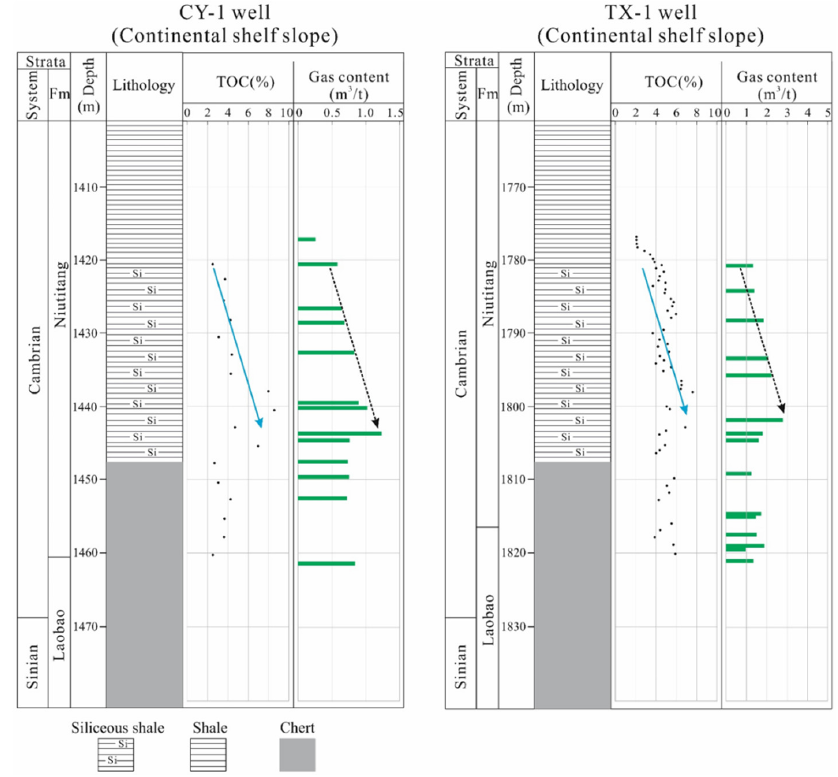
Figure 13. Depth profiles of the total organic carbon (TOC) content and shale gas content for the Niutitang shale at the Cen’gong section (data obtained from [13]). The floor interval with low permeability dense chert is conducive to the preservation of shale gas. Gas content increases with the TOC. Fm = Formation.